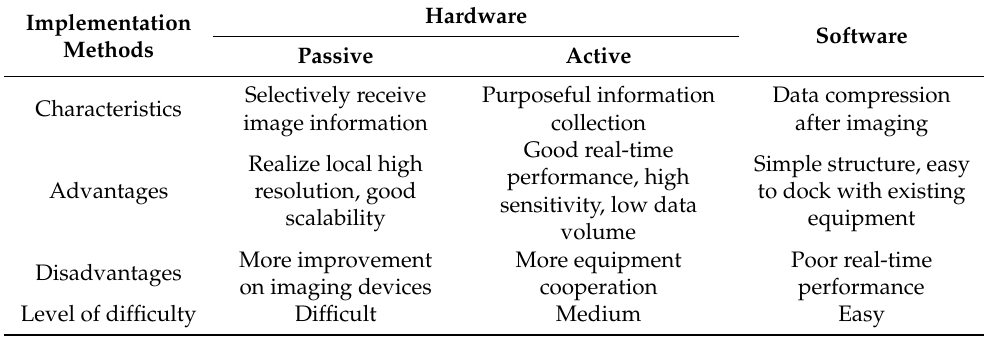
Table 1. Comparison of different methods.